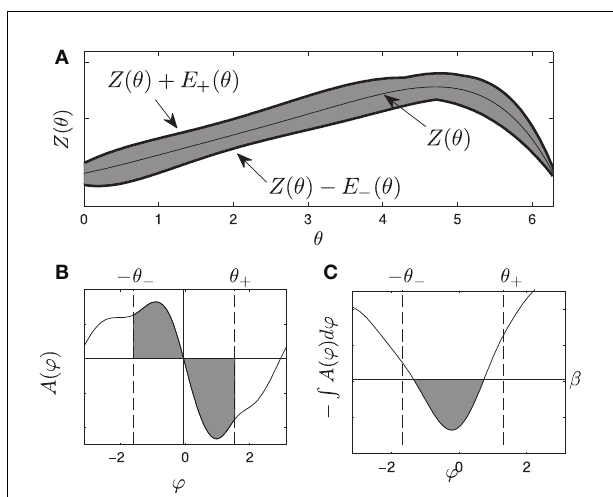
FIGURE 1 | (A) gives a visual representation of the uncertainty allowed in the phase response curve from Equation (1) , i.e., any PRC that can be drawn inside the shaded region is allowable. (B) shows an example of A ( ψ ) . gives a visual representation of the requirements Equations (10) and (11) , for any oscillator with any allowable PRC, the area of each shaded region in (B) must be at least β . If this is the case, the resulting potential well in (C) will be at least β high by the time ψ is smaller than − θ − or larger than θ +